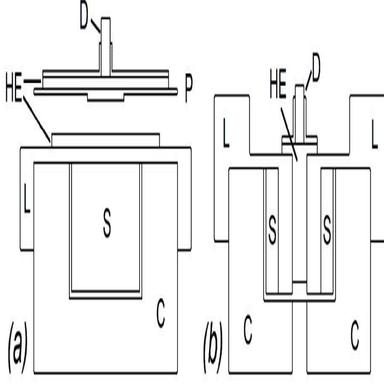
Schematic of the encapsulation test setups: configuration A (a) and configuration B (b).